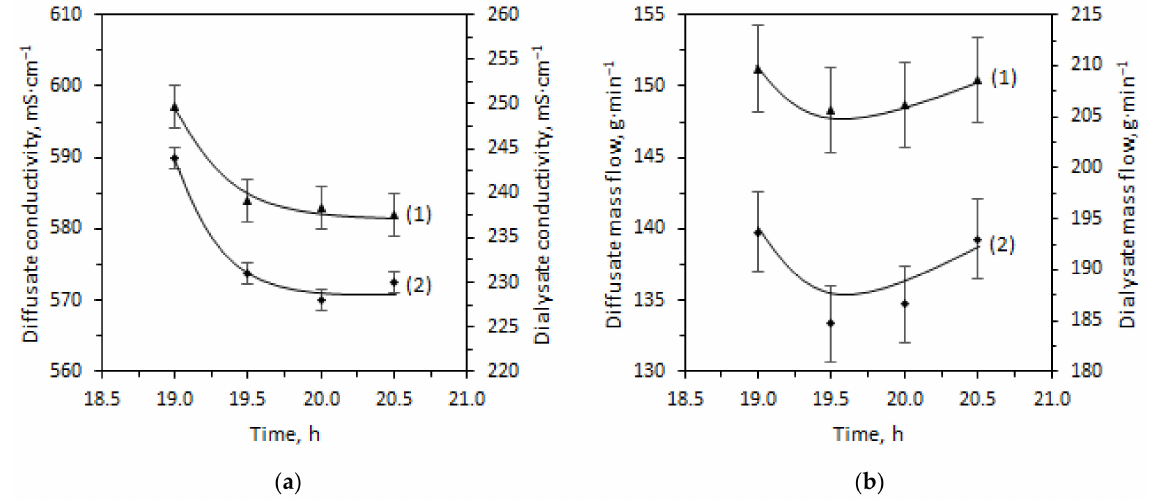
Figure 2. Electrical conductivity ( a ) and mass flowrate ( b ) of the output streams for Test 2; (1) ( ▲ ) diffusate, (2) ( ◆ ) dialysate.